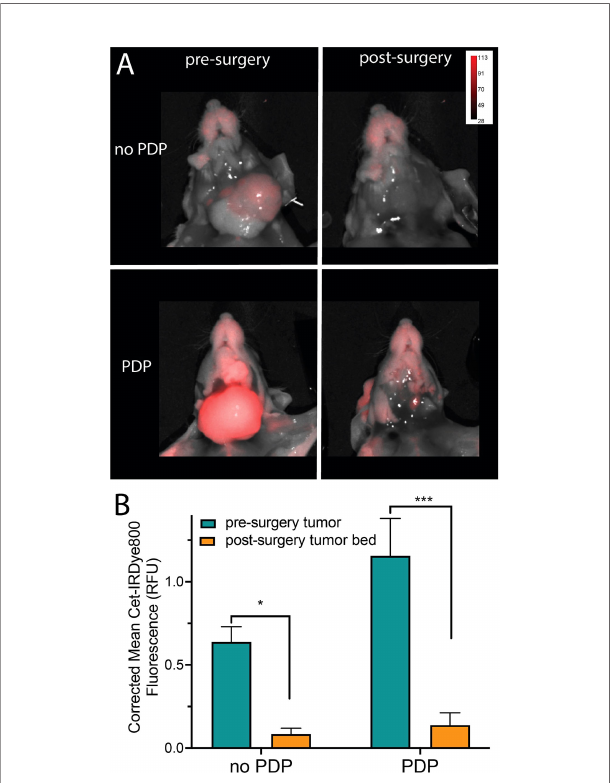
FIGURE 4 | (A) Representative fl uorescence and white light combined images of tumors subjected to PDP (bottom) and no PDP (top) pre- (left) and post-surgical debulking (right) of the tumor. (B) Comparison of mean Cet- IRDye800 fl uorescence intensity in the tumors with and without PDP, both before and after surgical debulking of the tumors. (Values are mean ± S.E.M.; statistical analysis was performed using one-way ANOVA with a Tukey post- test (B) ; * P ≤ 0.05, *** P ≤